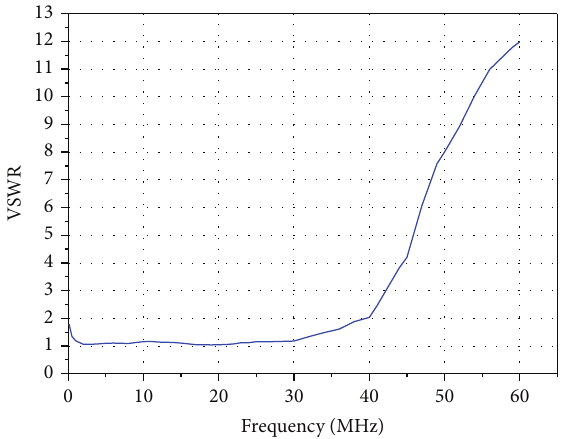
Figure 10: VSWR variation of the active antenna with